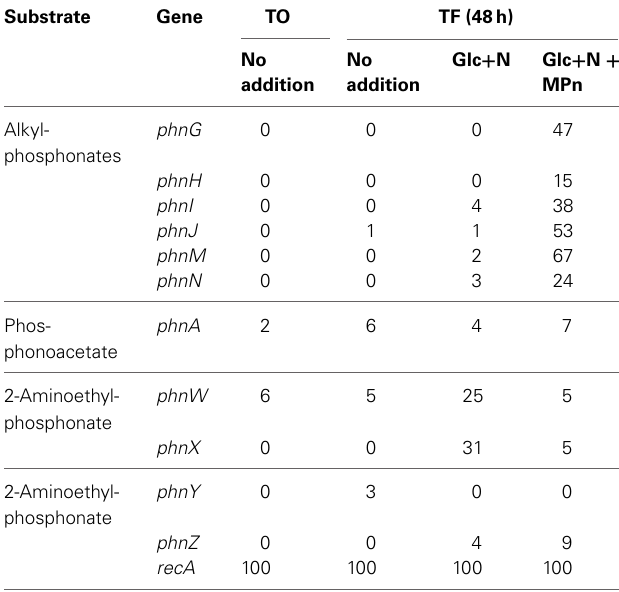
Table 1 | Abundance of phn genes in genomic DNA pyrosequencing libraries.